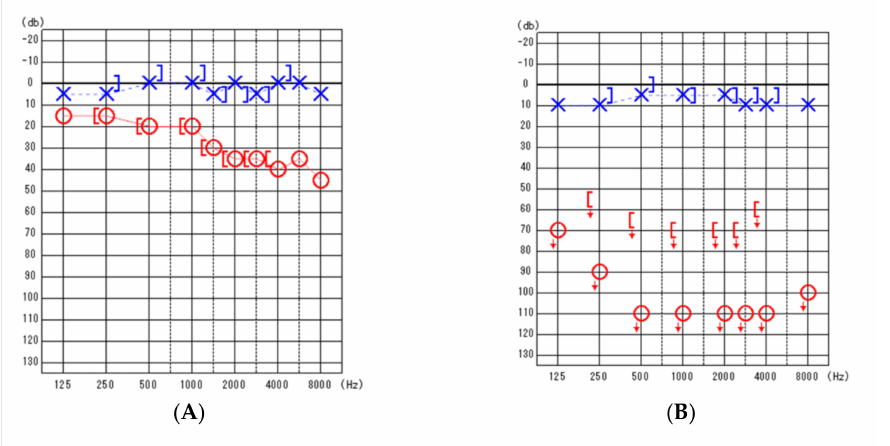
Figure 1. Pure-tone audiometric findings. ( A ) ( left ): Preoperative findings. ( B ) ( right ): Post-operative findings. Blue, left ear; Red, right ear; blue X, left ear air conduction threshold; red O, right ear air conduction threshold; [ , right ear measured with bone conduction threshold; ] , left ear measured with bone conduction threshold; ↓ , scale out